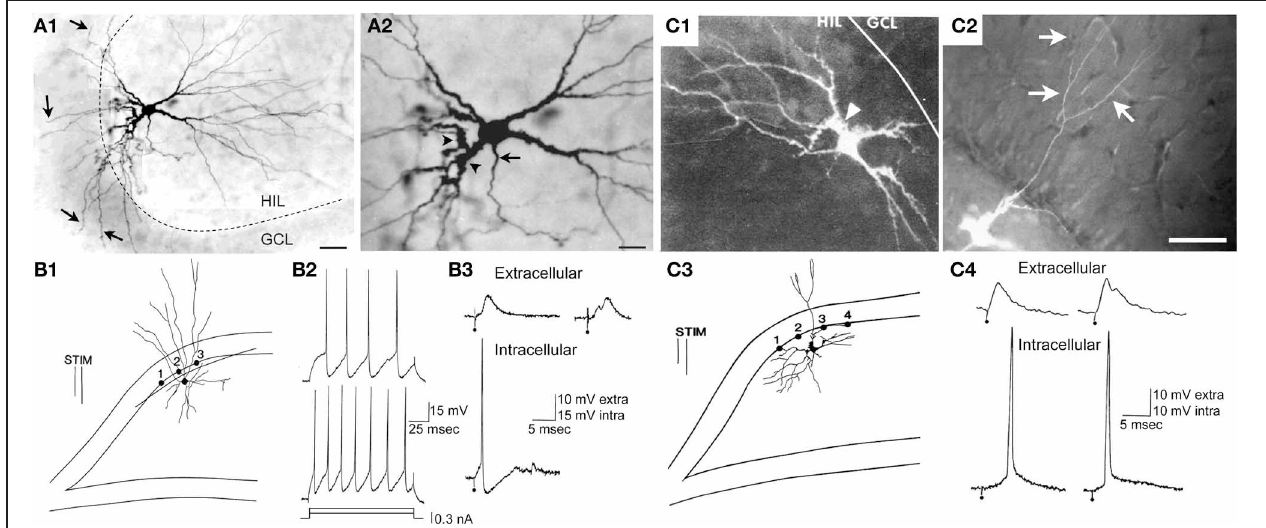
FIGURE 6 | A subset of hilar cells have low thresholds in response to electrical stimulation of the perforant path in rat hippocampal slices. (A1) Mossy cells often have dendrites in the molecular layer if their cell body is located near the granule cell layer. A Neurobiotin-filled physiologically-identified mossy cell is shown as an example. There are numerous dendrites entering the granule cell layer (GCL) and molecular layer (arrows). The dotted line marks the border of the HIL and GCL. Calibration = 80 μ m. (A2) The same cell is shown at higher magnification. The arrow indicates the axon; arrowheads mark thorny excrescences. More examples are shown in Scharfman (1991). Calibration = 40 μ m. (A) is from Scharfman et al. (2001). (B1) A drawing of a hilar interneuron with a low threshold is shown. (B1–B3) Are sites where the response to electrical stimulation of the molecular layer was recorded to evaluate granule cell responses to the same stimulus. The bipolar stimulating electrode is indicated by two parallel lines (STIM). (B2) Intracellular current (0.15, 0.3nA) was used to evaluate firing behavior, and the responses demonstrated typical firing of GABAergic neurons: weak spike frequency adaptation. (B3) Top (extracellular): the response recorded extracellularly at site #1 at weak (left) and strong (right) intensities of stimulation. Bottom (intracellular): simultaneously recording of